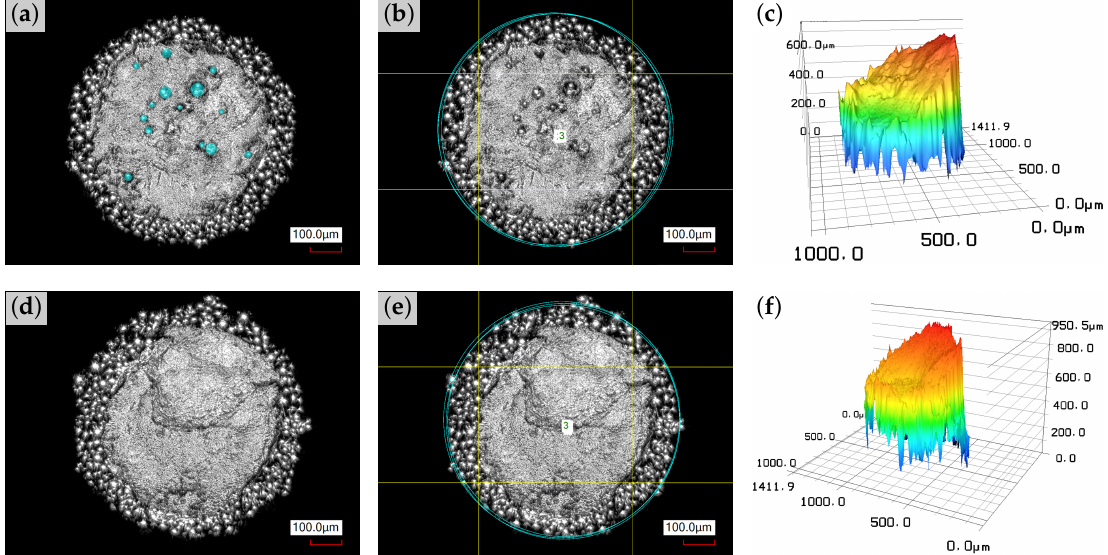
Figure 3. Confocal laser microscopy of the fracture surfaces of the test samples L10D07 ( a – c ) and L10D07S ( d – f ). Observed pores marked blue in ( a ), not present in ( d ). Outside diameter measurement of the struts in ( b , e ). 3D model of each fracture surface respectively in ( c , f